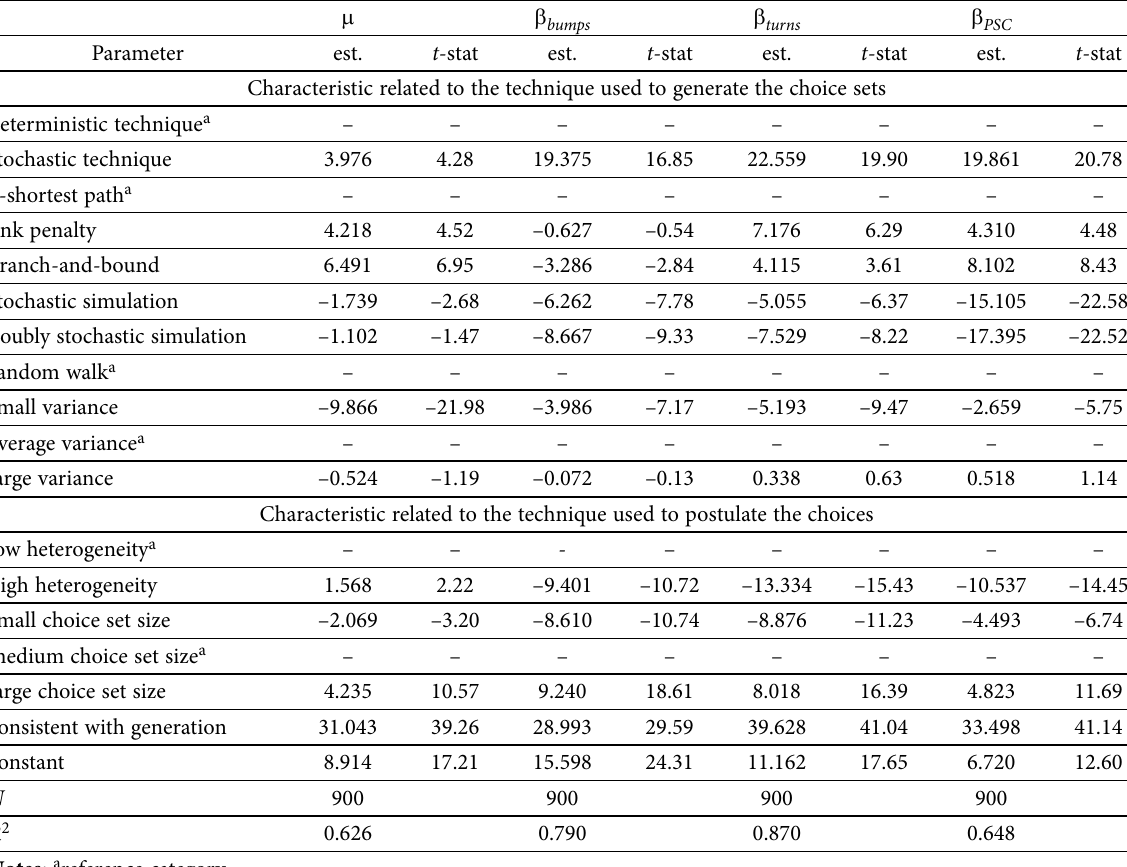
Table 7. Meta-analysis estimates of the accuracy of single parameters